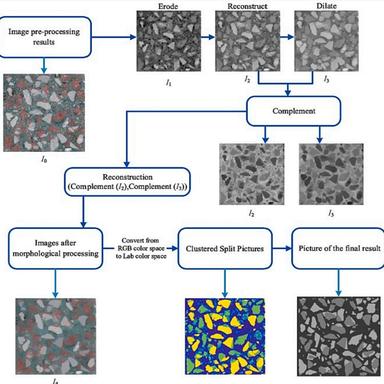
Flowchart of semi-automatic labelling process Note: 1) "Erode" indicates an image erosion operation. 2) "Reconstruct" indicates a morphological reconstruction operation on the image. 3) "Dilate" indicates an image expansion operation. 4) "Complement" indicates the inverse operation on the image. 5) "Reconstruction (Complement (I2), Complement (I3))" indicates the Reconstruct operation on the result after Complement. 6) After morphological processing of the graph, the picture becomes blurred, making the imp